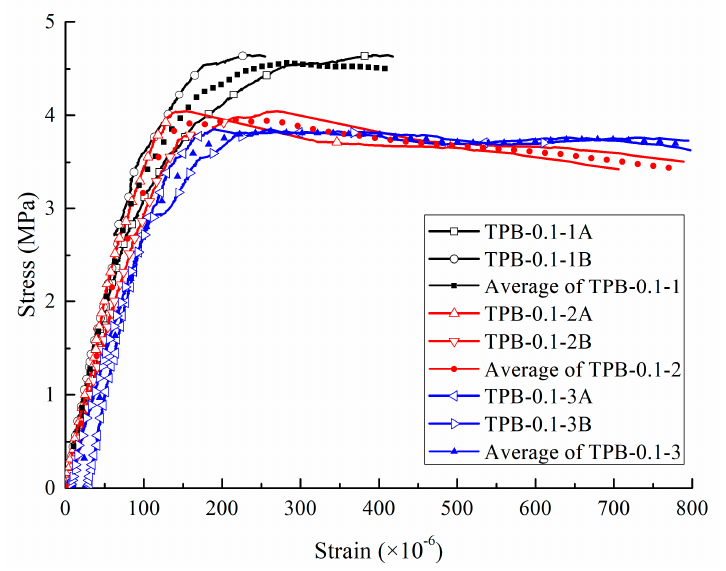
Figure 5. Stress-strain curves of three specimens under the static loading.